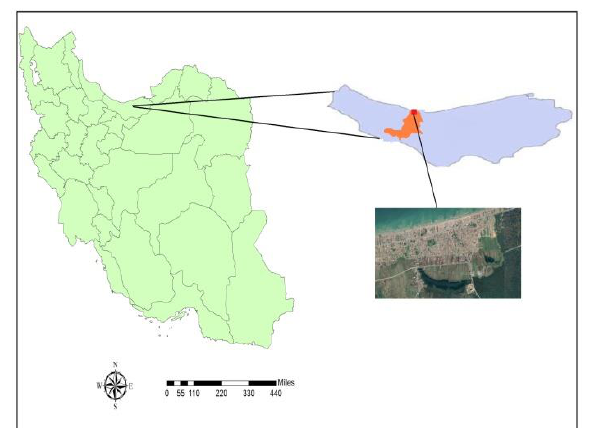
Figure 1. Location of study area in Iran. Orange colour shows Nur city. Landsat image (bottom-right map) shows study